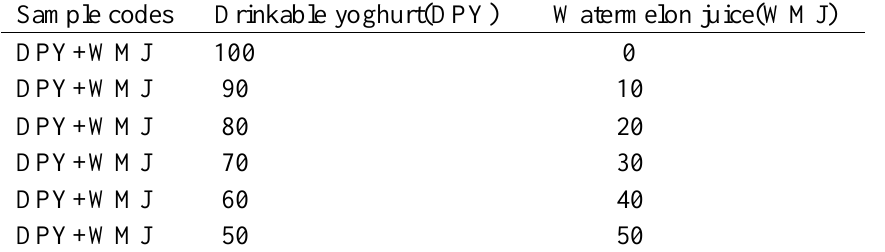
Table 2: Proportion for the formulated drinkable yoghurt with watermelon juice Sample